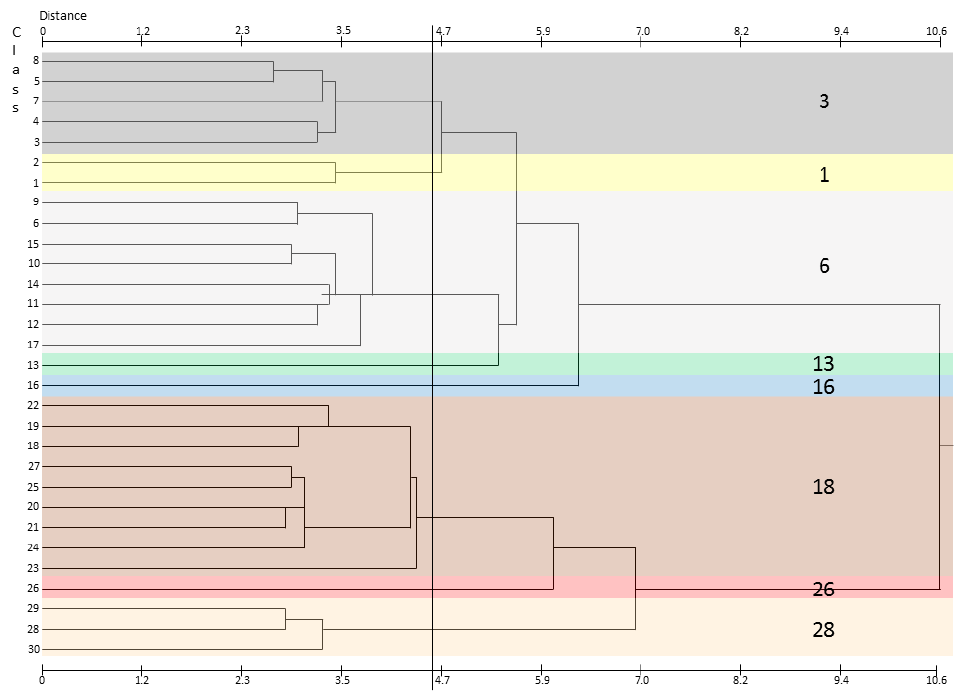
Figure 8. Dendrogram produced from the initial unsupervised classification illustrating the 30 classes that were hierarchically clustered to eight for the image mapping product each color represents the color of the final aggregated class displayed in Figure 9, the black line indicates the threshold used for aggregation.